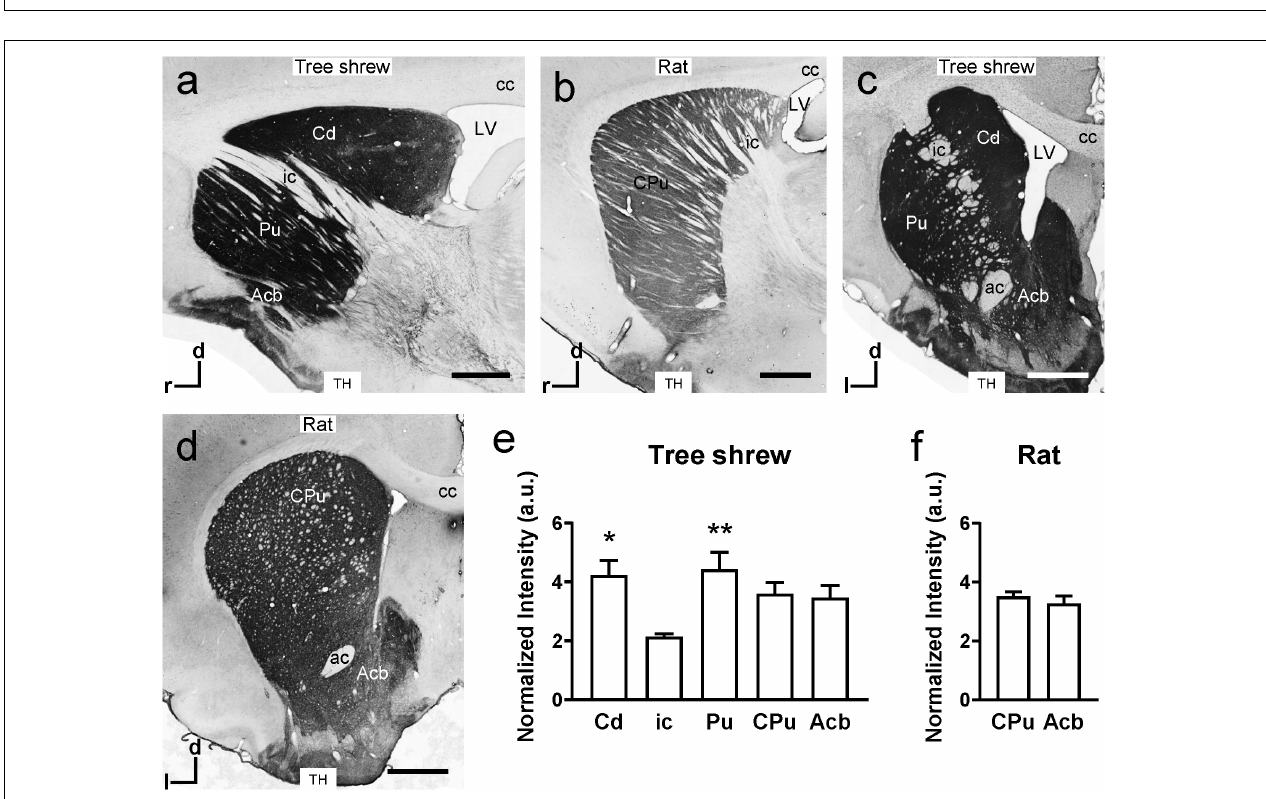
FIGURE 4 | Comparison of tyrosine hydroxylase (TH) immunoreactivity in the striatum of tree shrews and rats. (a,b) Bright-field photomicrographs of TH immunoreactivity are shown in sagittal sections of the tree shrew and rat striata. (c,d) Low-magnification photomicrograph illustrating TH immunoreactivity in coronal sections of the striatum in tree shrews and rats. (e) A graph showing the normalized intensity of TH-ir fibers in the caudate nucleus (Cd), internal capsule (ic), putamen (Pu), and accumbens nucleus (Acb) of tree shrews. (f) Comparison of the normalized intensity of TH-ir fibers in the caudate putamen (CPu) and Acb of the rat striatum. Values are expressed as the mean ± SEM. * P < 0.05, ** P < 0.01 compared with the ic. Scale bars = 1000 µ m in (a–d) . ac, anterior commissure; cc, corpus callosum; d, dorsal; l, lateral; LV, lateral ventricle; r,